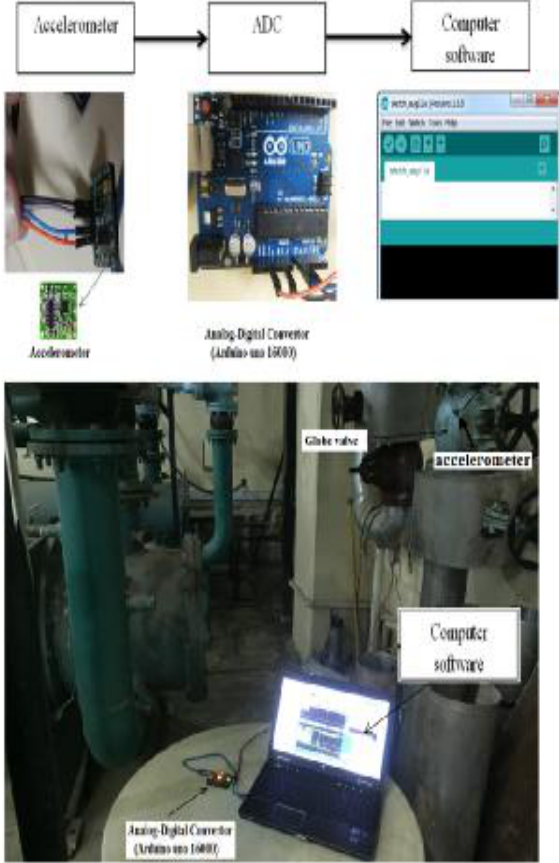
Fig. 3. Flow diagram of vibration signal and vibration measurement devices.